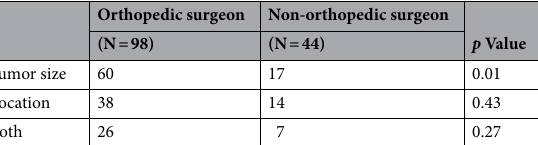
Table 4. Comparisons between orthopedic surgeons and non-orthopedic